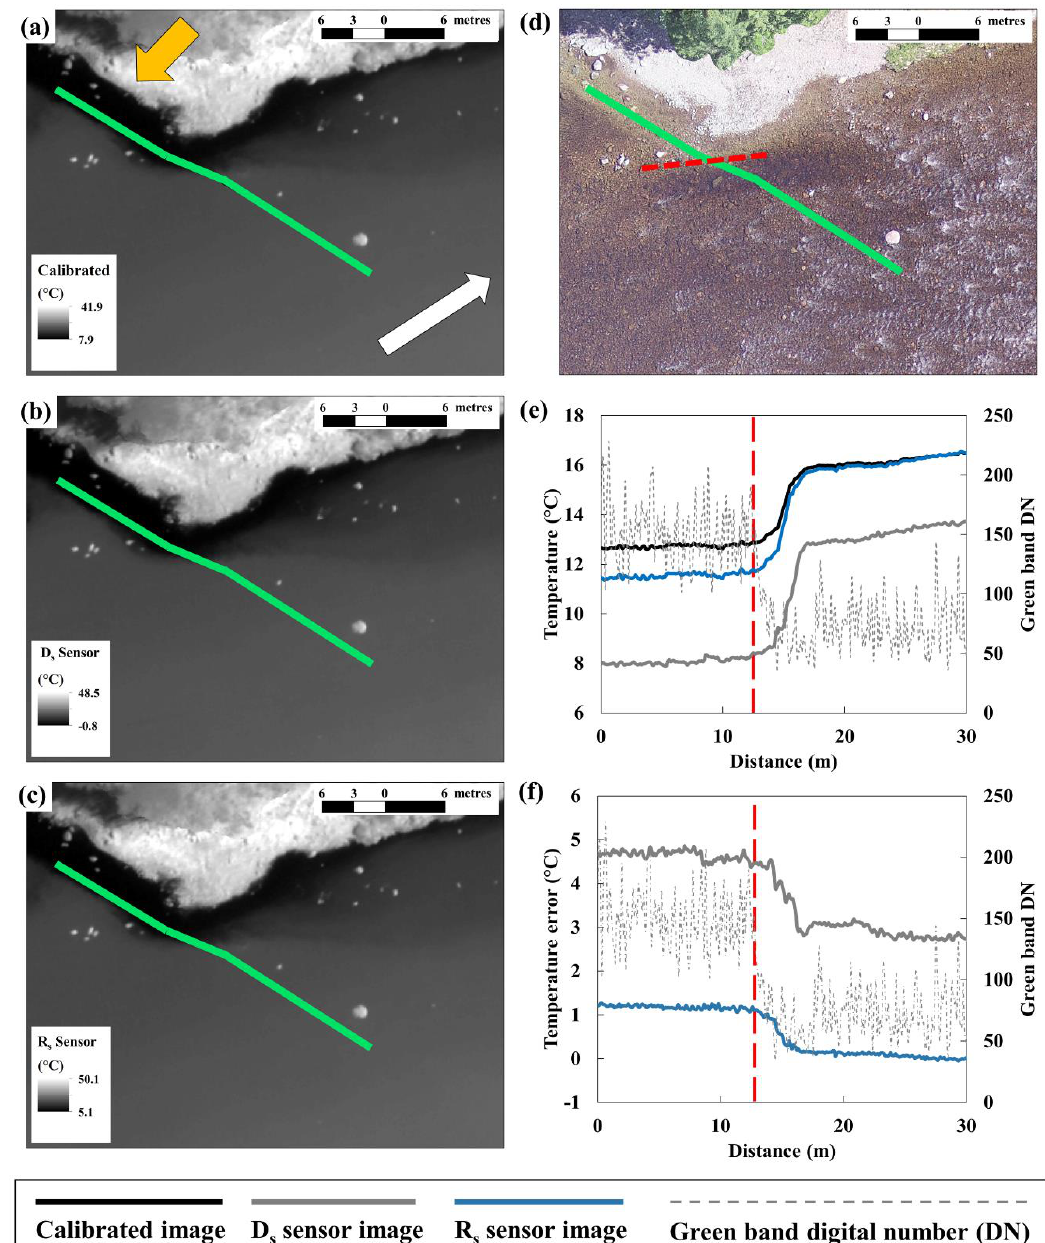
Figure 10. ( a ) TIR imagery from flight 8 on 29 June at 10:16 (see Table 2) calibrated with observations from n = 12 instream temperature loggers, where the yellow arrow denotes Ryan Brook, and the white arrow delimits the rivers flow direction. ( b ) TIR image from the D s sensor, flight 7 on 29 June at 10:01. ( c ) TIR imagery from the R s sensor from flight 8, also used as the calibration image. The RGB image in ( d ) illustrates the variability of river-bed colour, where the change from Ryan Brook and the main stem is denoted by the red dashed line, and the green profile in ( a – d ) corresponds with the thermal profiles in ( e , f ). The different T R measurements from the calibrated image, the D s sensor, and the R s sensor are shown in ( e ), and super-imposed on the corresponding variability in the images’ green band digital number (DN)— a proxy for reflectance — where the red dashed line corresponds to the red dashed line in ( d ). Temperature measurement errors between the calibrated TIR image and the D s and R s T R measurements are shown in ( f ), where a decrease in DN values leads to a reduction in errors for both sensors.